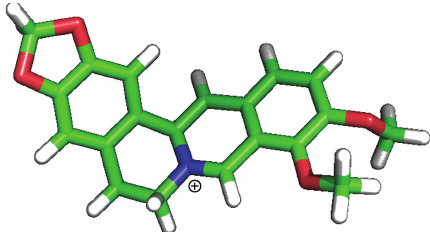
Figure 1: Chemical structure of berberine.